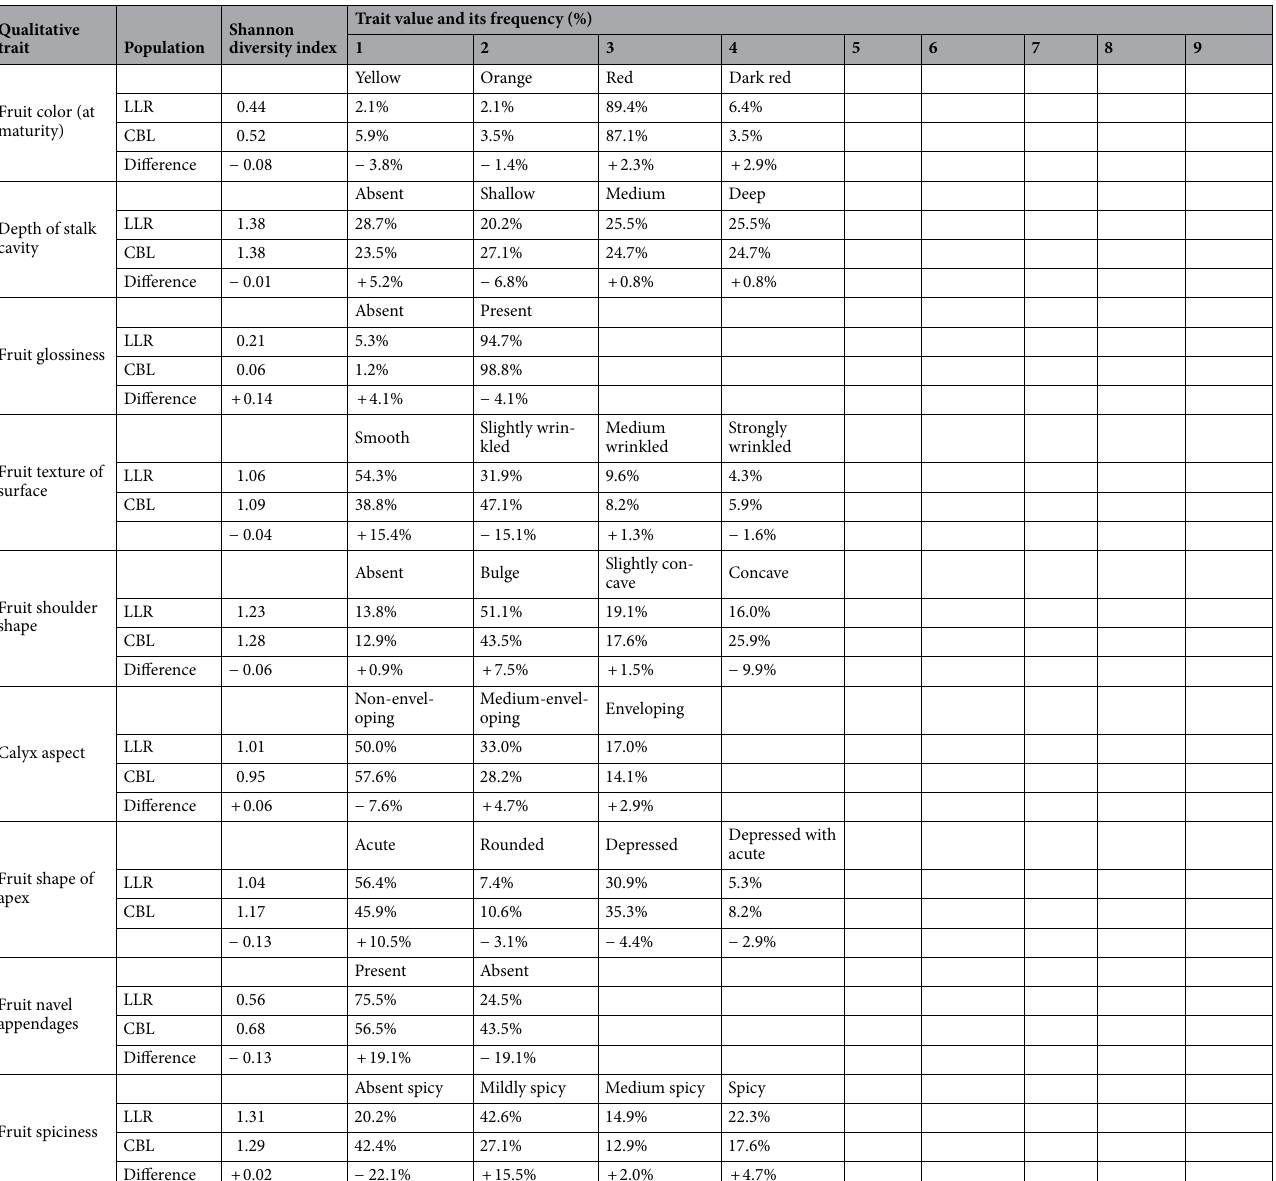
Table 2. Distribution frequencies and Shannon Diversity indexes and their differences for 22 qualitative traits evaluated in 94 local landraces (LLR) and 85 current breeding lines (CBL) of pepper in